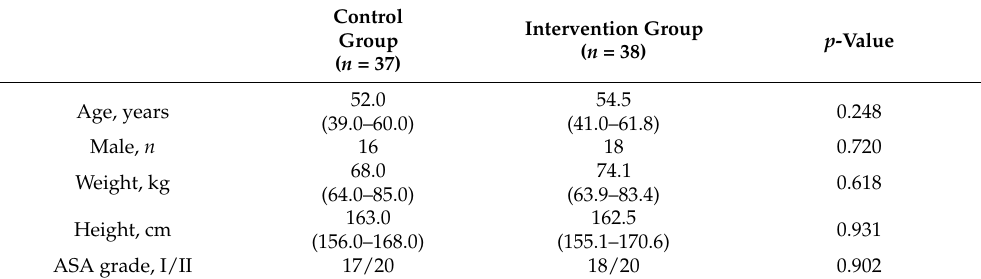
Table 1. Baseline characteristics before and after propensity score Table 2. Operational data.